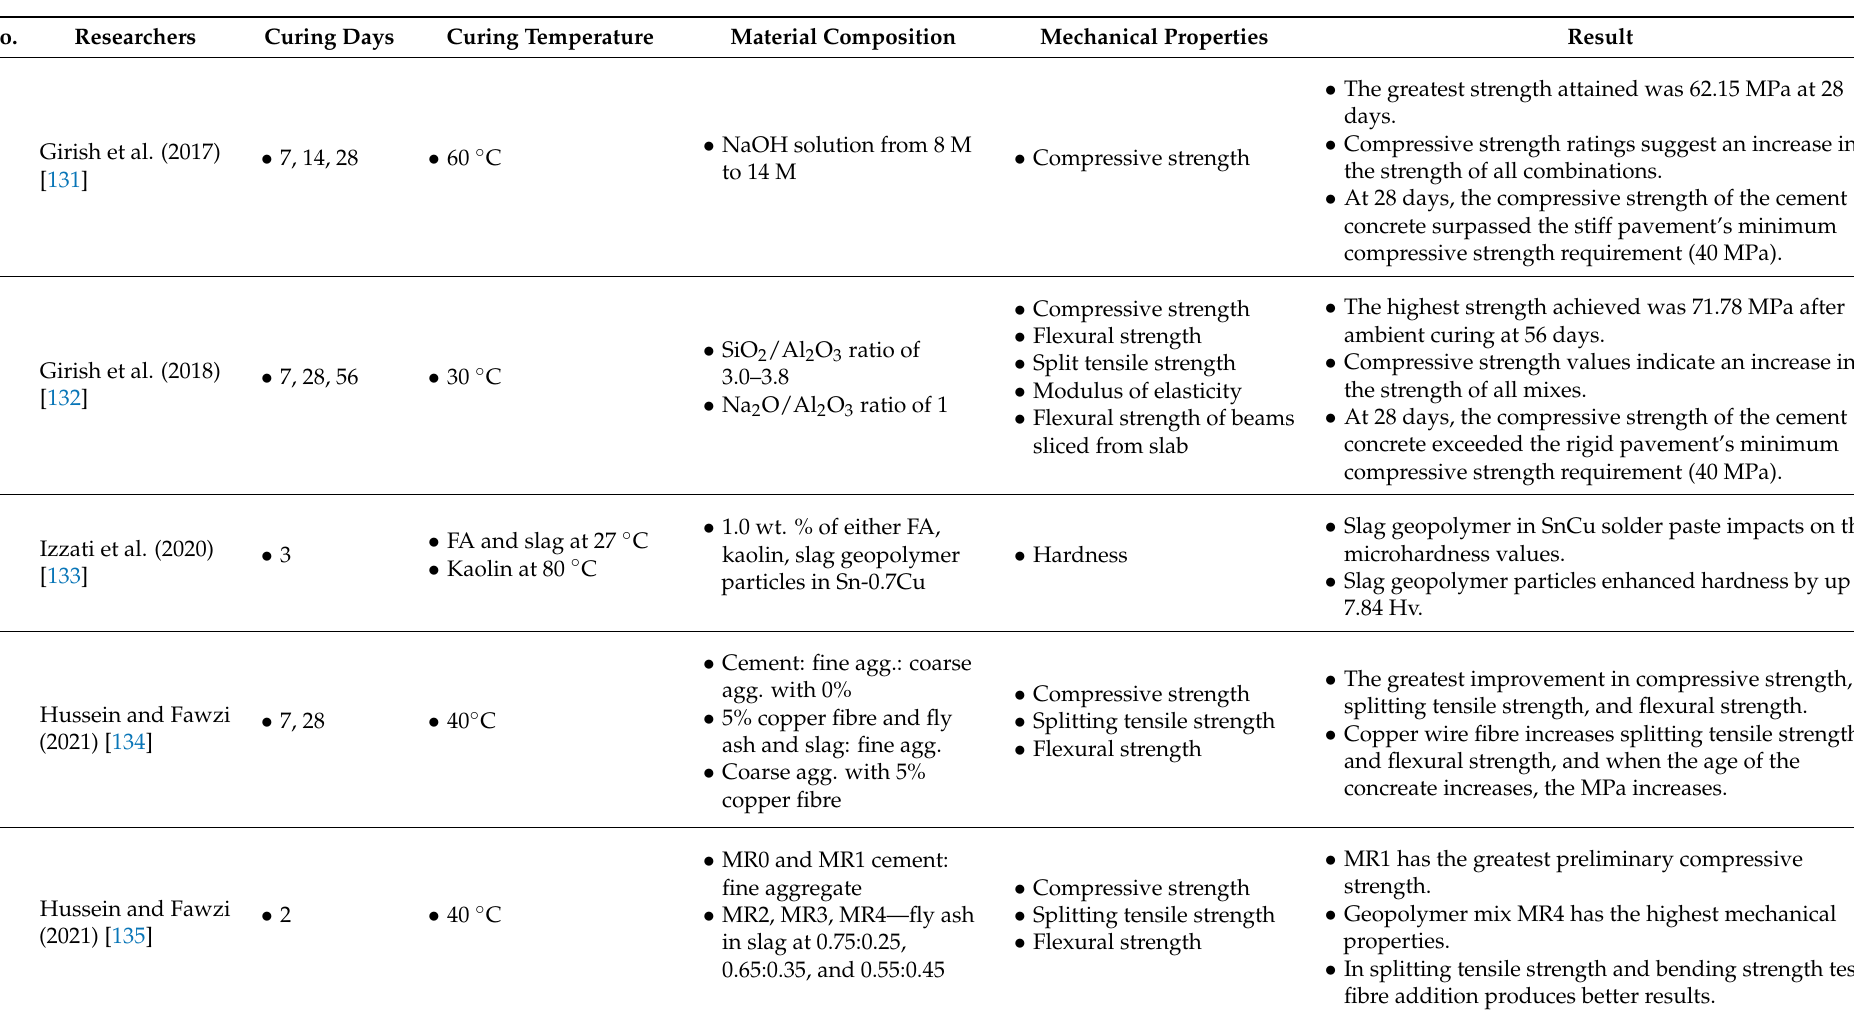
Table 6. Research on the effects of different geopolymer compositions on mechanical